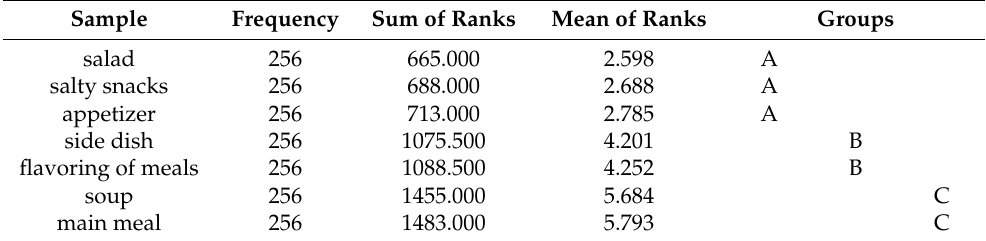
Table 6. Differences in the evaluation of preferred mushrooms meals in the “heavy consumers”